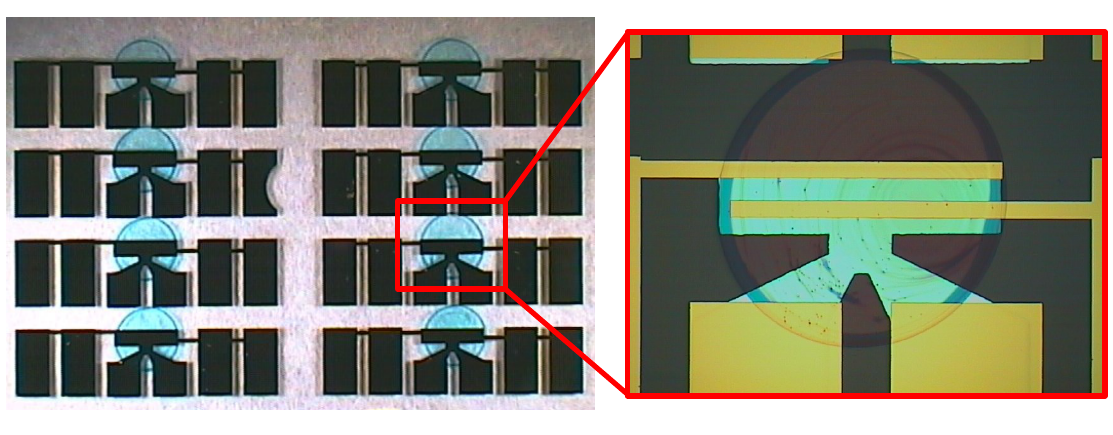
Figure 8. Set of eight transistors with drop-coated FS111 using an automated dispensing system and a single transistor showing the coverage of the semiconductor on the gate.